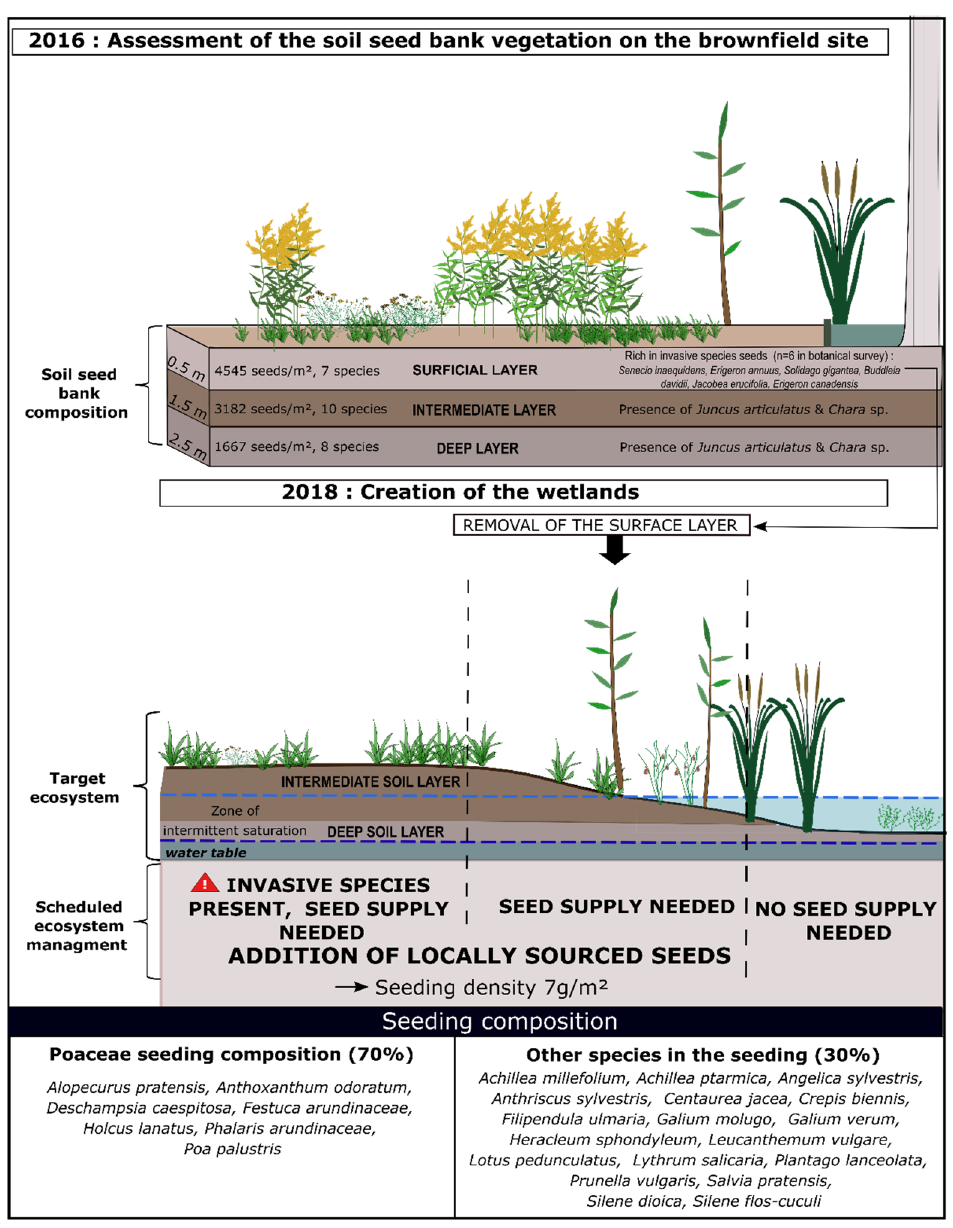
Figure 2. Vegetation restoration scheme for the created wet meadow habitats following an initial soil seed bank analysis and a botanical inventory of the brownfield site in 2016.